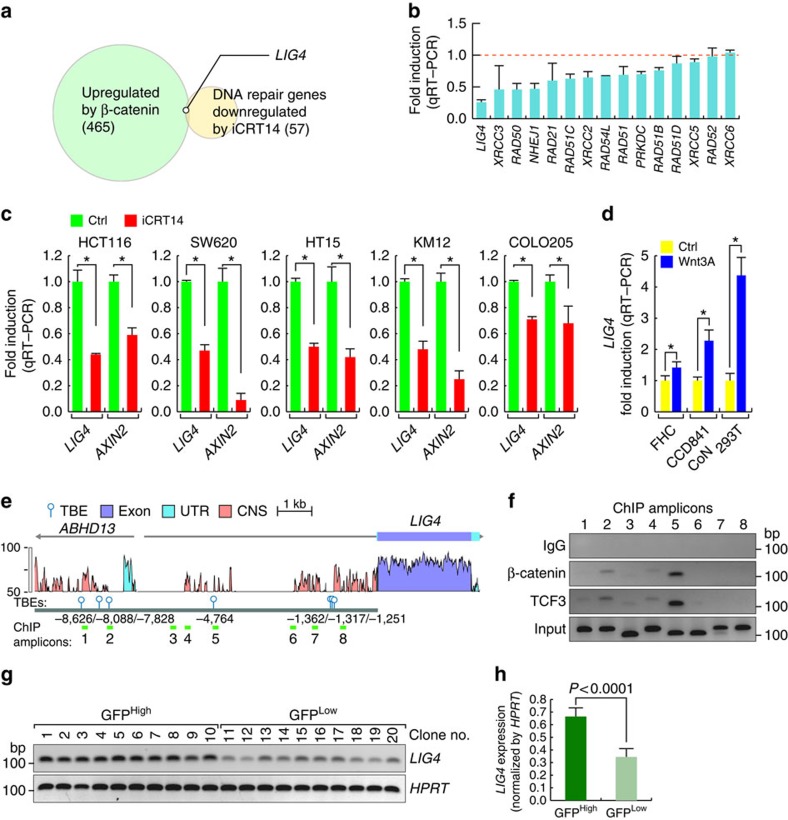
LIG4 transactivation by β-catenin.(a) Identification of β-catenin target genes. DNA repair genes that are upregulated by β-catenin (465 genes) and downregulated by iCRT14 (50 μM for 24 h; 57 genes) were identified. Notably, LIG4 is both upregulated by β-catenin and downregulated by iCRT14. Fold change > 2; P<0.005. Student's t-test; N=3. (b) Identification of NHEJ genes downregulated by β-catenin inhibition. HCT116 cells were treated with iCRT14 (50 μM for 24 h) and analyzed for expression of NHEJ repair genes using qRT-PCR. Student's t-test; N=3; error bars=±SEM. (c) Downregulation of LIG4 by iCRT14 in CRC cells. CRC cells (HCT116, SW620, HT15, KM12 and COLO205) were treated with iCRT14 (50 μM for 24h) and analyzed by qRT-PCR. AXIN2 served as a positive control for the β-catenin target gene. Student's t-test; N=3; *P<0.05; error bars=±s.e.m. (d) Upregulation of LIG4 by Wnt3A in IECs. Human IECs (FHC and CCD841CoN) and 293T cells were treated with Wnt3A (200 ng ml−1 for 24 h) and analysed by qRT–PCR. Student's t-test; N=3; *P<0.05; error bars=±s.e.m. (e) LIG4 promoter analysis. Conserved noncoding sequences (CNS) found in both the mouse and human LIG4 promoter were analysed for potential TCF/LEF-binding elements (TBEs; balloons). UTR: untranslated region. (f) β-catenin transcriptional complex occupies LIG4 promoter. HCT116 cells were analysed by ChIP assays. ChIP amplicons (1–8) were detected by ChIP-PCR. (g,h) Upregulation of LIG4 in GFPHigh cells. SW620-7TGP CRC cells were sorted into GFPHigh and GFPLow cells, and clonally selected for semi-quantitative RT–PCR of LIG4 expression (g). ImageJ analysis of LIG4 expression normalized by hypoxanthine phosphoribosyltransferase 1 (HPRT) (h). Student's t-test; N=3; *P<0.05; error bars=±s.e.m.